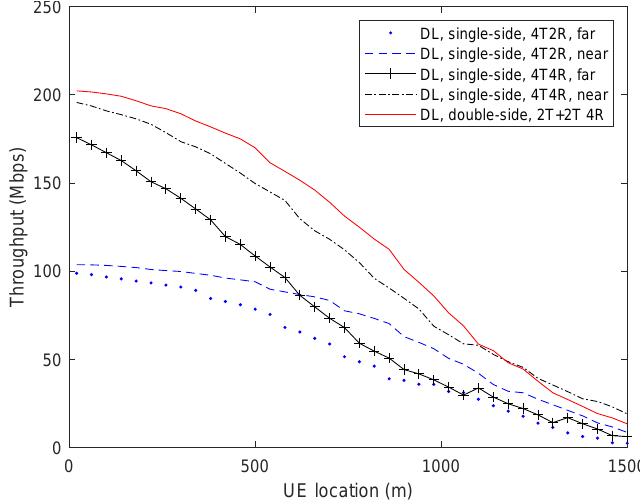
Figure 11. The throughput of different deployments with four